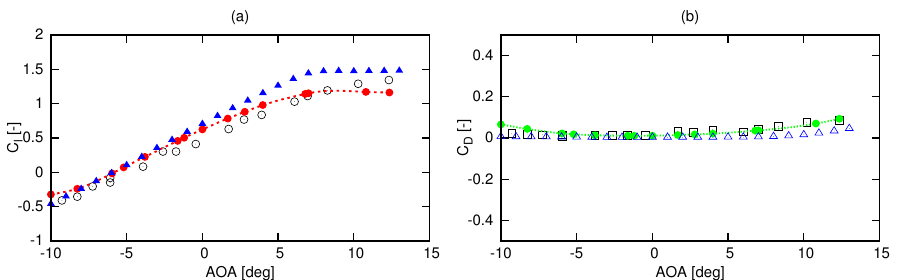
Figure 5. Comparison of RANS (red and green dots) and XFOIL (blue and green triangles) results with the experimental values, where ( a ) represents lift coefficients (Cl) vs. angles of attack (AOA) and ( b ) represents drag coefficients (Cd) vs.